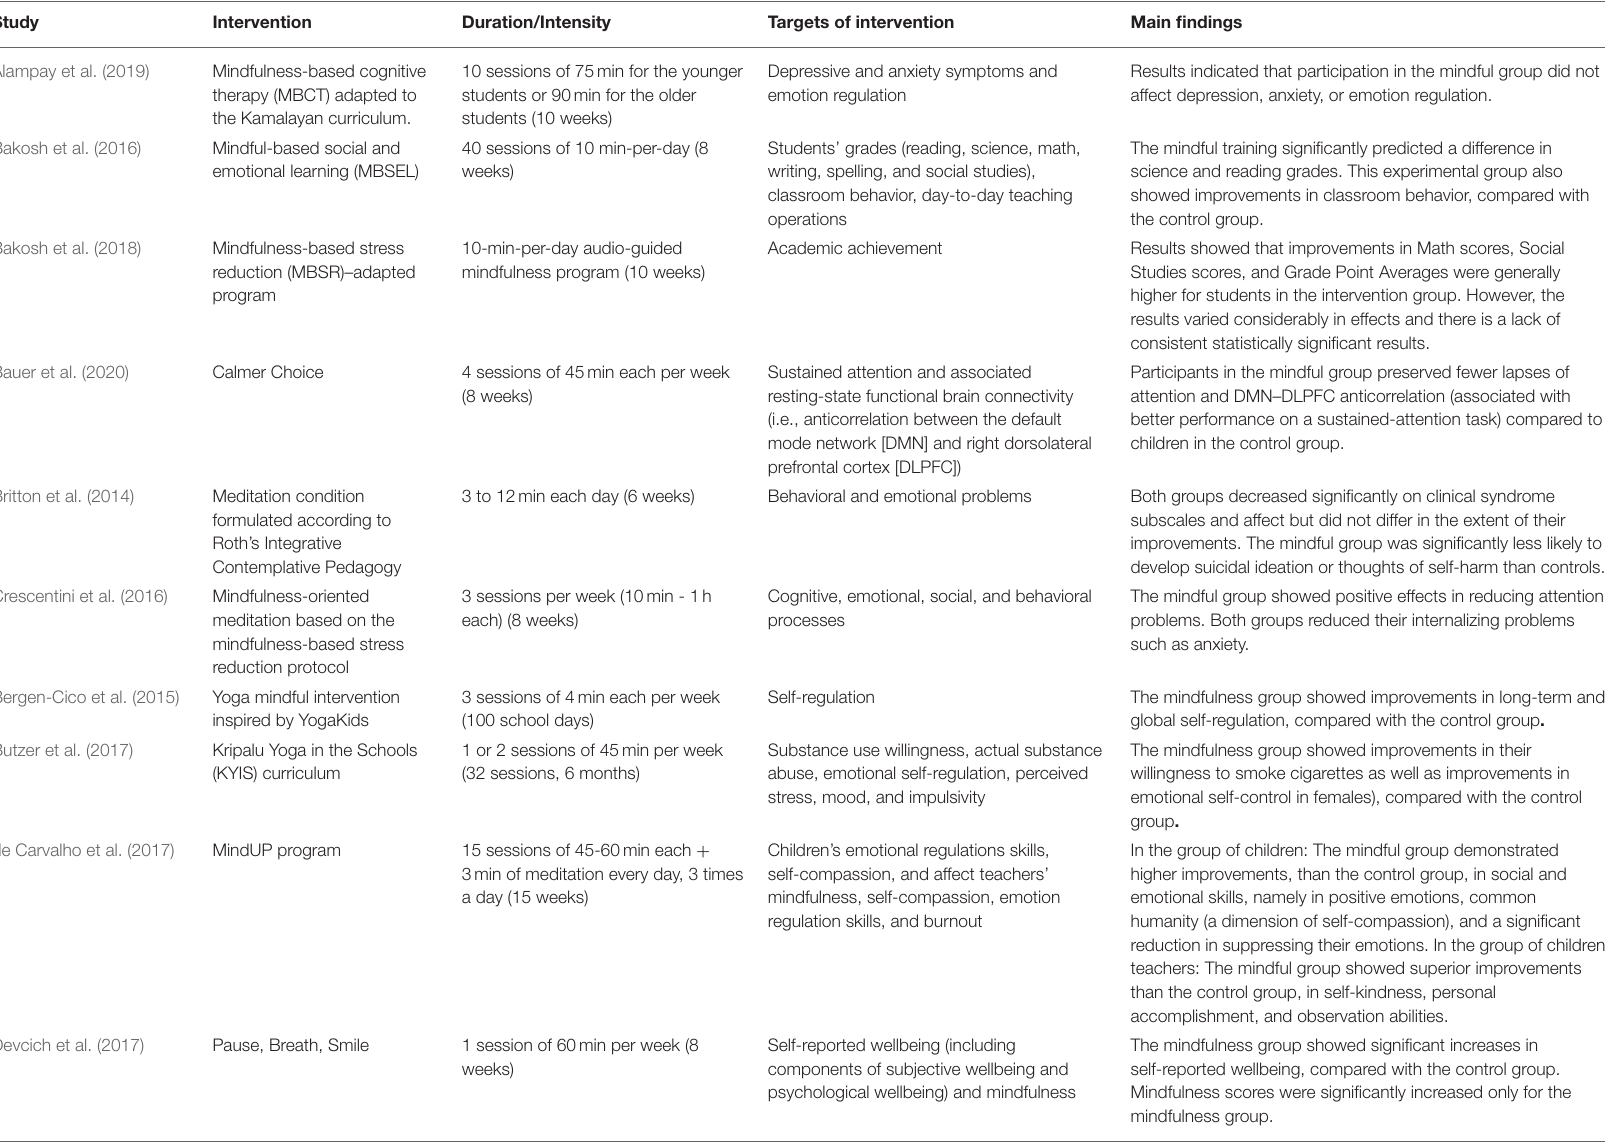
TABLE 3 | Intervention characteristics, meditation techniques, and main findings of the included